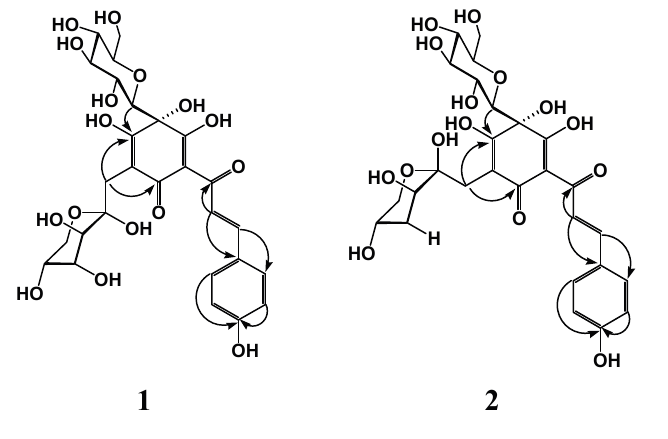
Figure 2. Selected heteronuclear multiple bond correlation (HMBC) for compounds 1 and 2